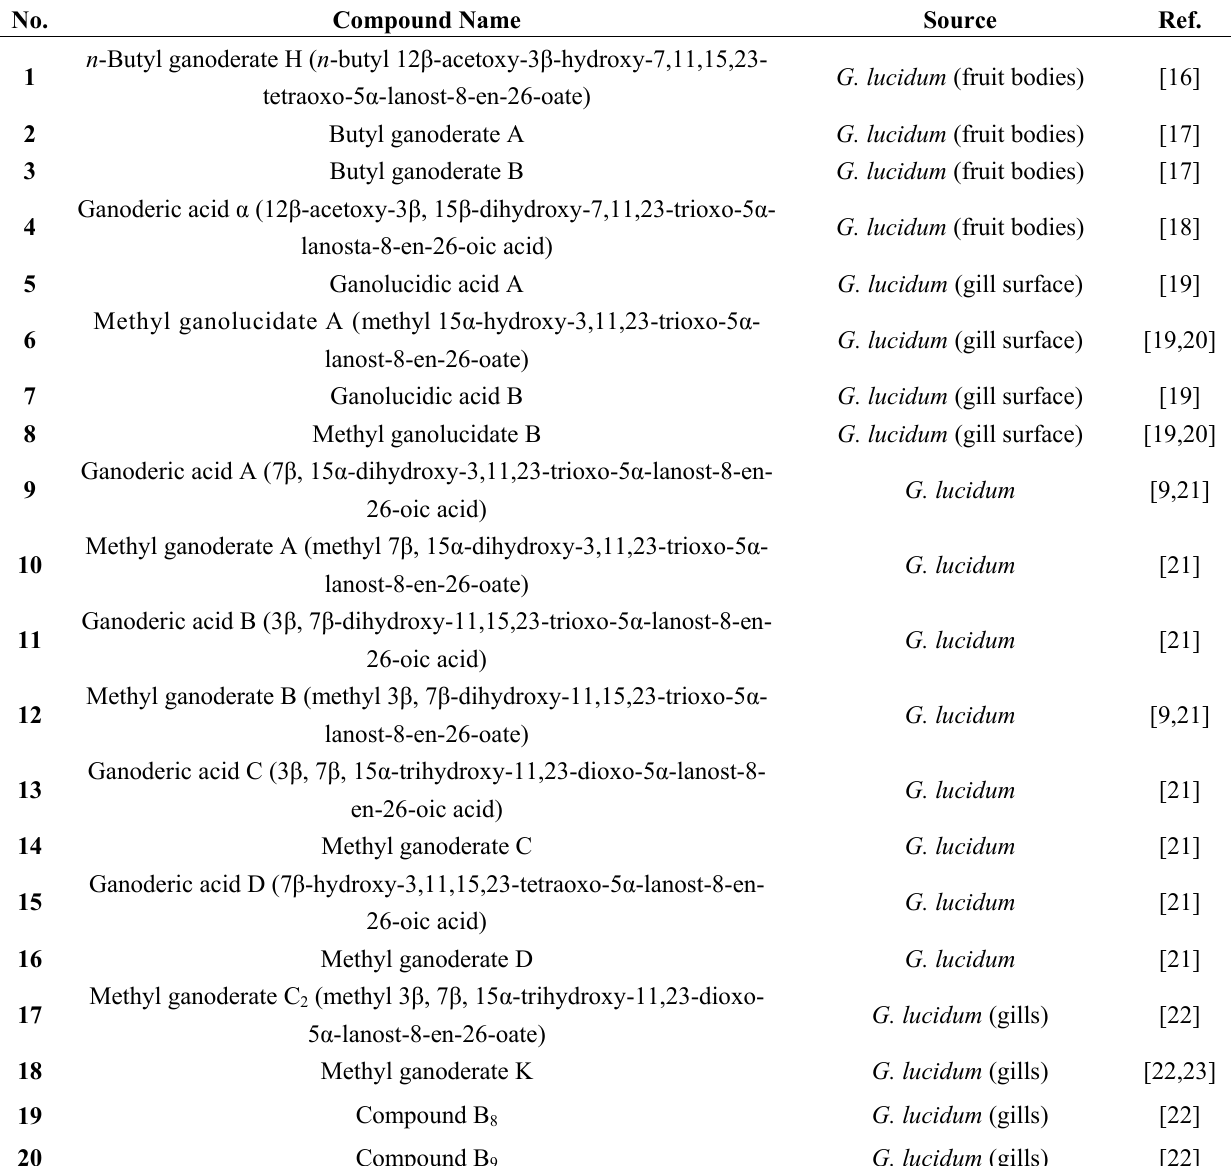
Table 1. Ganoderma triterpenes 1 – 37 in Figure